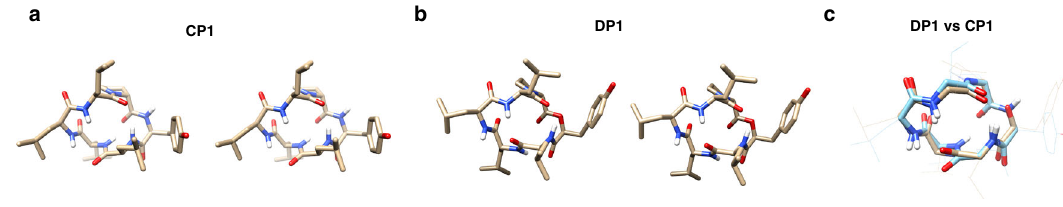
Fig.3|NMRsolutionstructuresofCP1andDP1. StereoviewsofNMRsolutionstructuresof aCP1 and bDP1 inCDCl 3 . c Thesuperpositionof DP1 with CP1 . DP1 isshown in brown and CP1 is shown in blue. The root mean square deviation (RMSD) value is shown under the